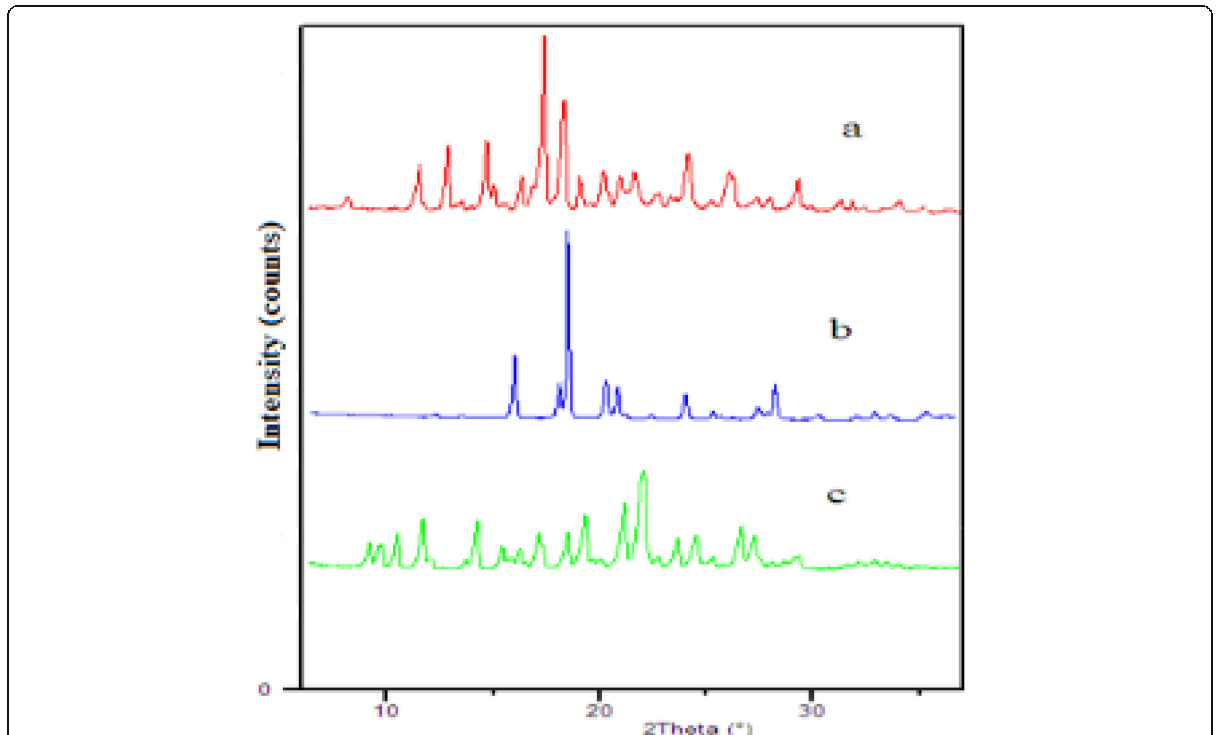
Fig. 5 a PXRD patterns of CAR. b PXRD patterns of HCT. c PXRD patterns of